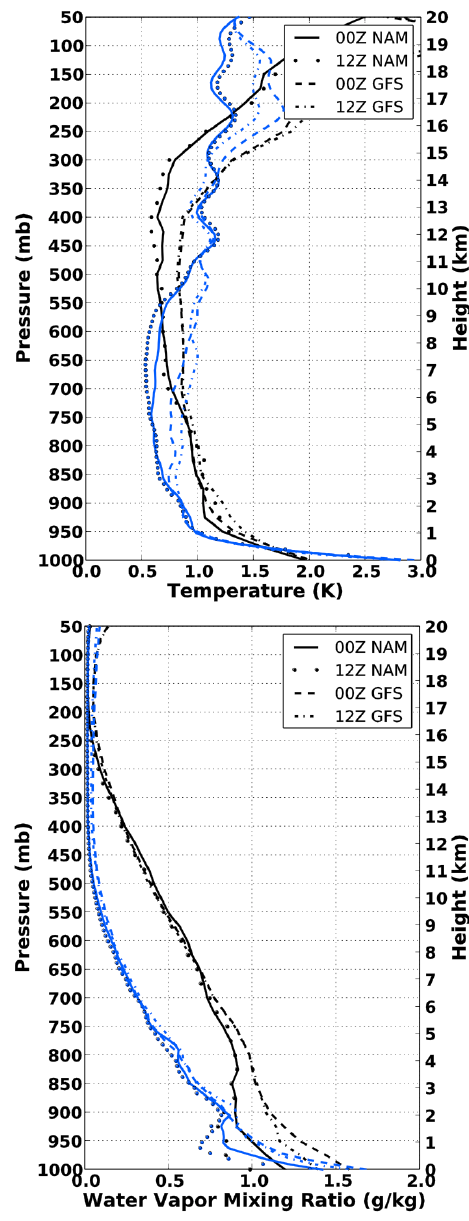
Fig. 1 Ensemble RMS differences between RAOB measurements and corresponding NWP analysis temperature (left) and water vapor mixing ratio (right) profiles. Each panel illustrates the errors for 0Z and 12Z NWP analysis fields respectively. The black lines represent the respective RMS differences as a function of pressure and the blue lines denote the RMS as a function of vertical height from the surface.